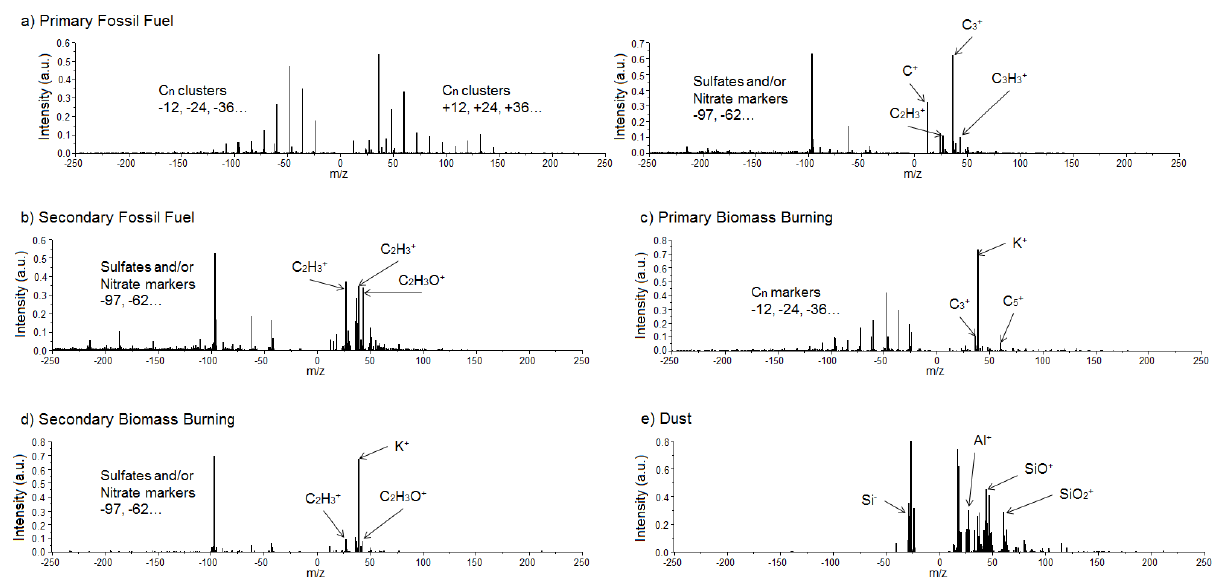
Fig. 3. Representative A-ATOFMS spectra for different aerosol sources (a) primary fossil fuel, (b) secondary fossil fuel, (c) primary biomass burning, (d) secondary biomass burning, and (e) dust. Figure 3. Representative A-ATOFMS spectra for different aerosol sources a) Primary fossil fuel, 3 Table 2. Location and data availability of the AERONET stations in b) Secondary fossil fuel, c) Primary biomass burning, d) Secondary biomass burning, and e) dust. 4